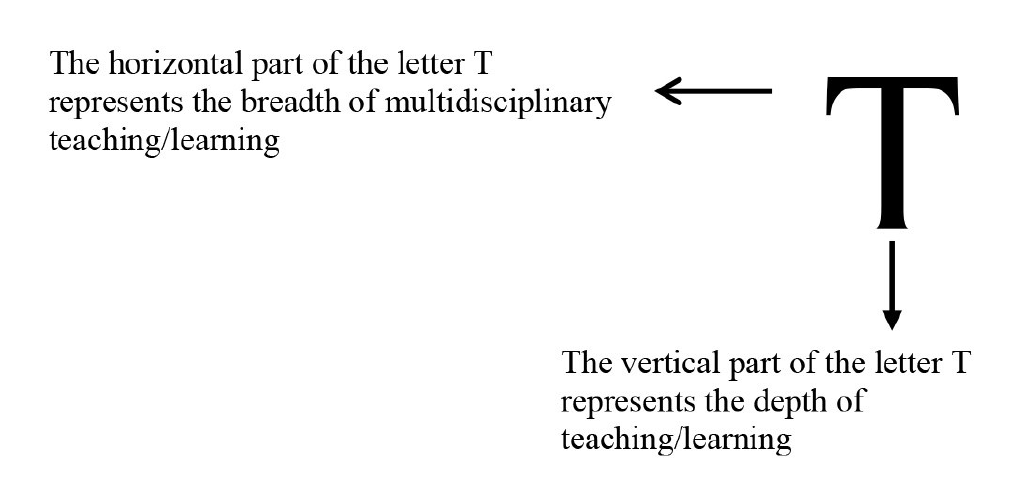
Figure 1. The T-shape